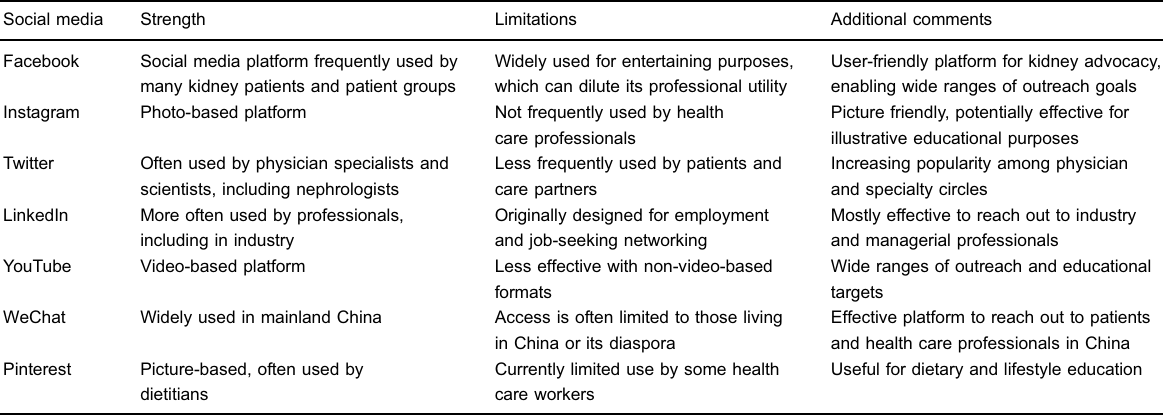
Table 2. Social media that are more frequently used for kidney education and